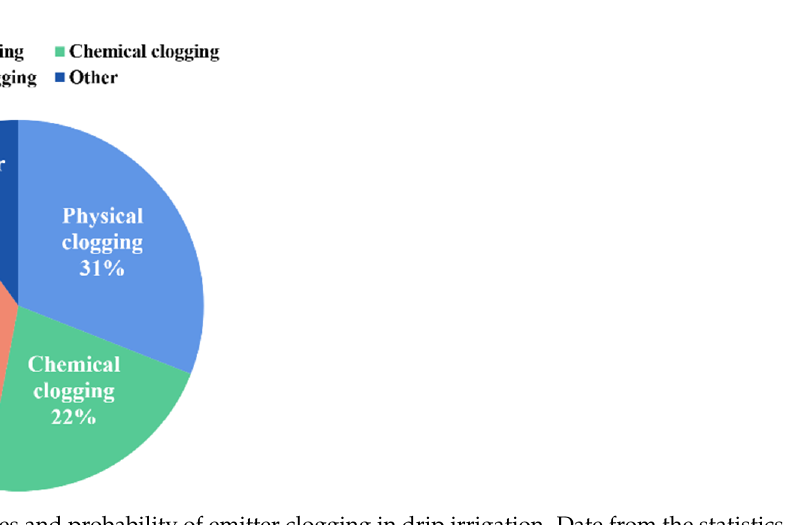
Table 1. Emitter clogging caused by solid particles under different water